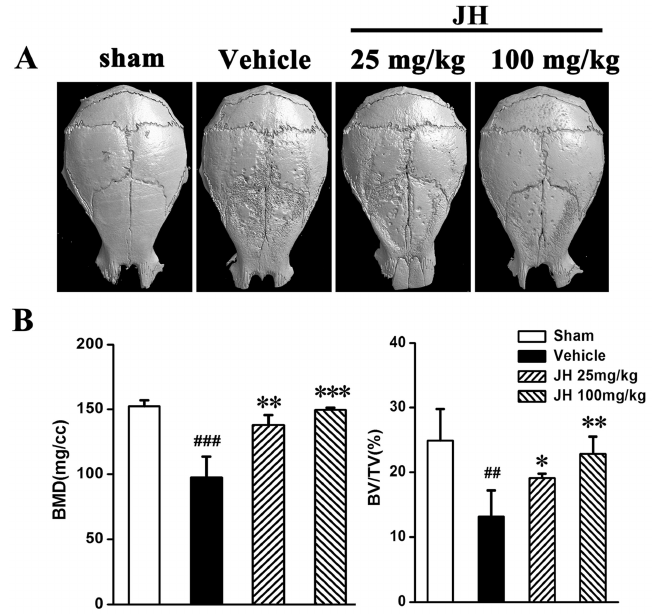
Figure 1. JH inhibits Ti particle-induced bone destruction in a mouse calvarial model. ( A ) Representative micro-CT 3D reconstructed images were obtained from different groups. ( B ) Bone mineral density (BMD) and bone volume/tissue volume (BV/TV) were determined using the CTan program (SkyScan). All the data were shown as mean ± SD; ## p < 0.01 and ### p < 0.001 versus sham group, * p < 0.05, ** p < 0.01 and *** p < 0.001 versus vehicle-treated Ti particle-induced group; n = 7 per